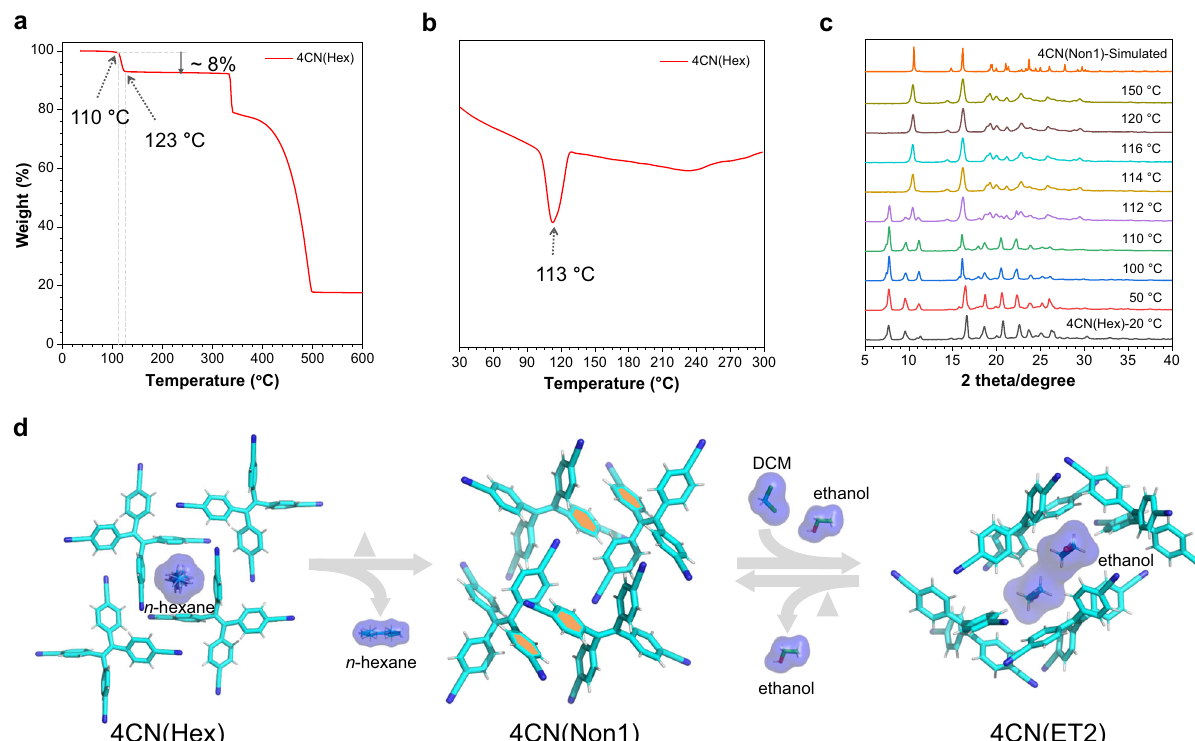
Fig. 5 The transformation of 4CN(Hex). a TGA, b DSC, and c variable-temperature PXRD of 4CN(Hex) crystals upon heating. d Structure transformation between porous 4CN(Hex) or 4CN(ET2) and nonporous 4CN(Non1) upon heating and solvent fuming. ‘ Δ ’ indicates